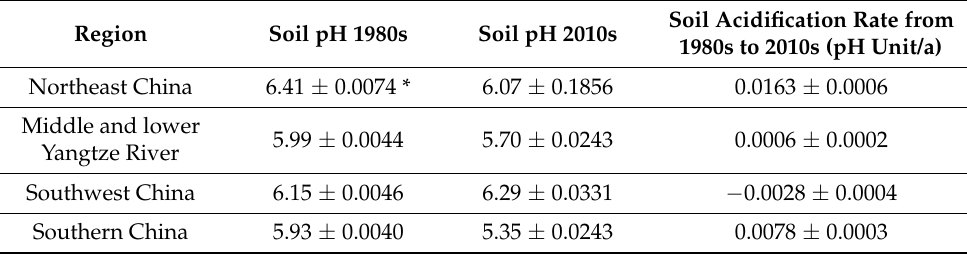
Table 2. Changes in paddy soil pH in the 0–20 cm layer from 1980 to 2010 in